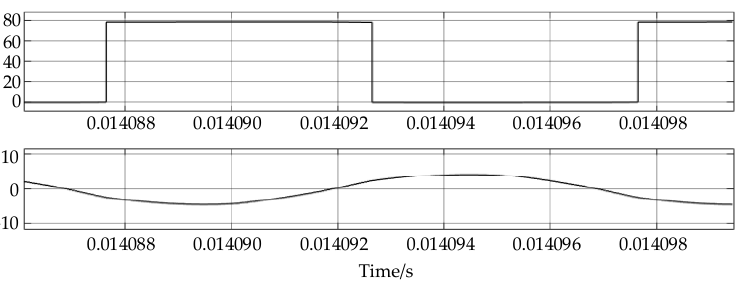
Figure 28. ϕ AD = 92 ◦ and ϕ AB = 239 ◦ bridge-arm B drain-source voltage and current waveforms.